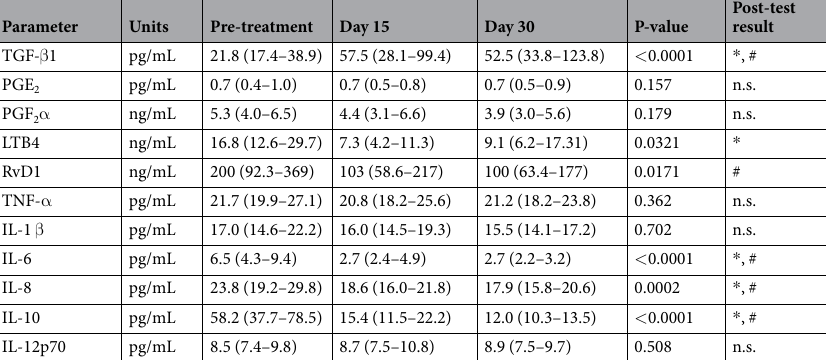
Table 4. Serum levels of inflammatory markers from patients with visceral leishmaniasis before and after leishmanicidal treatment initiation. Values represent median and interquartile ranges. Log10 transformed data (which presented Gaussian distribution) were analyzed using one-way ANOVA with Tukey’s multiple comparisons post-test. Column with P-values represent the one-way ANOVA comparisons. P-values from post- test are represented by the following: * p < 0.05 in Pre-treatment vs. Day 15; # p < 0.05 in Pre-treatment vs. Day 30; $ p < 0.05 in Day 15 vs. Day 30; n.s.